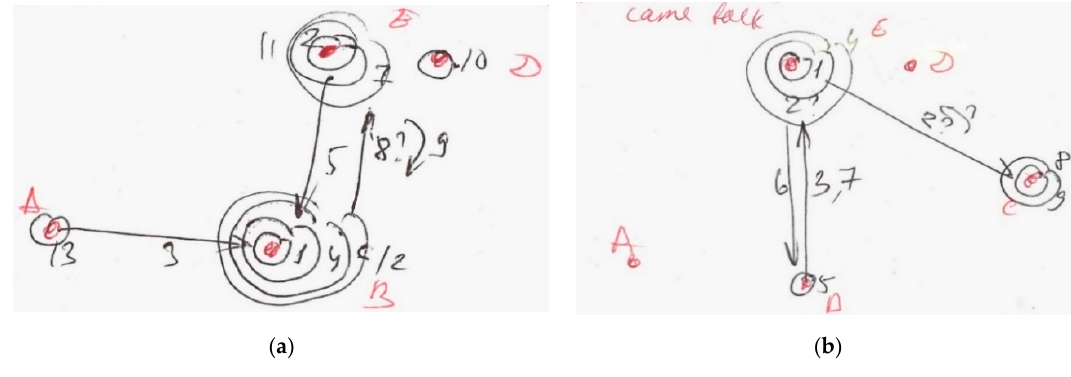
Figure 3. ( a ) Supervisor is absent; ( b ) supervisor (C) came back.